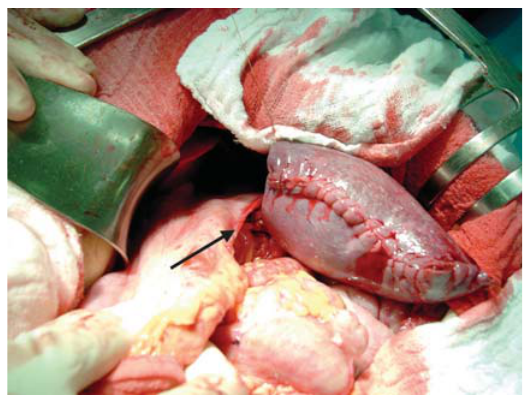
Figure 1 - Surgical aspect of subtotal splenectomy performed in a patient with portal hypertension. Observe the splenogastric vessels